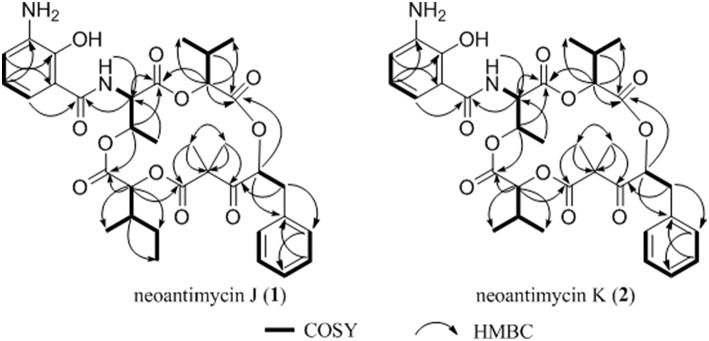
Key 1H-1H cozy and HMBC correlations for 1–2.